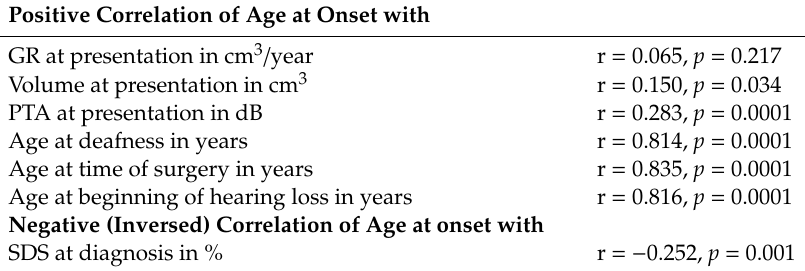
Table 4. Correlations of VS related parameters with age at onset.